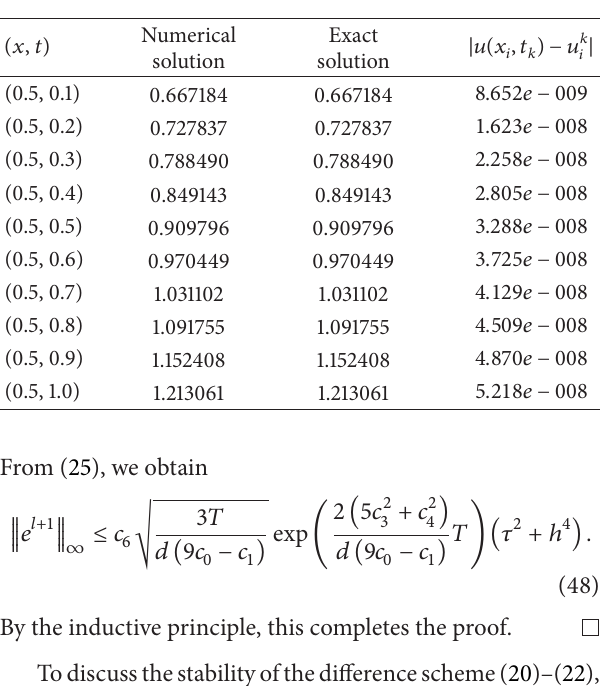
Table 1: Numerical results of (54) when ℎ = 1/10 , 𝜏 = 1/100